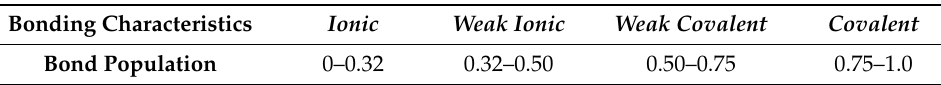
Table 5. Indicator of population analysis for electron